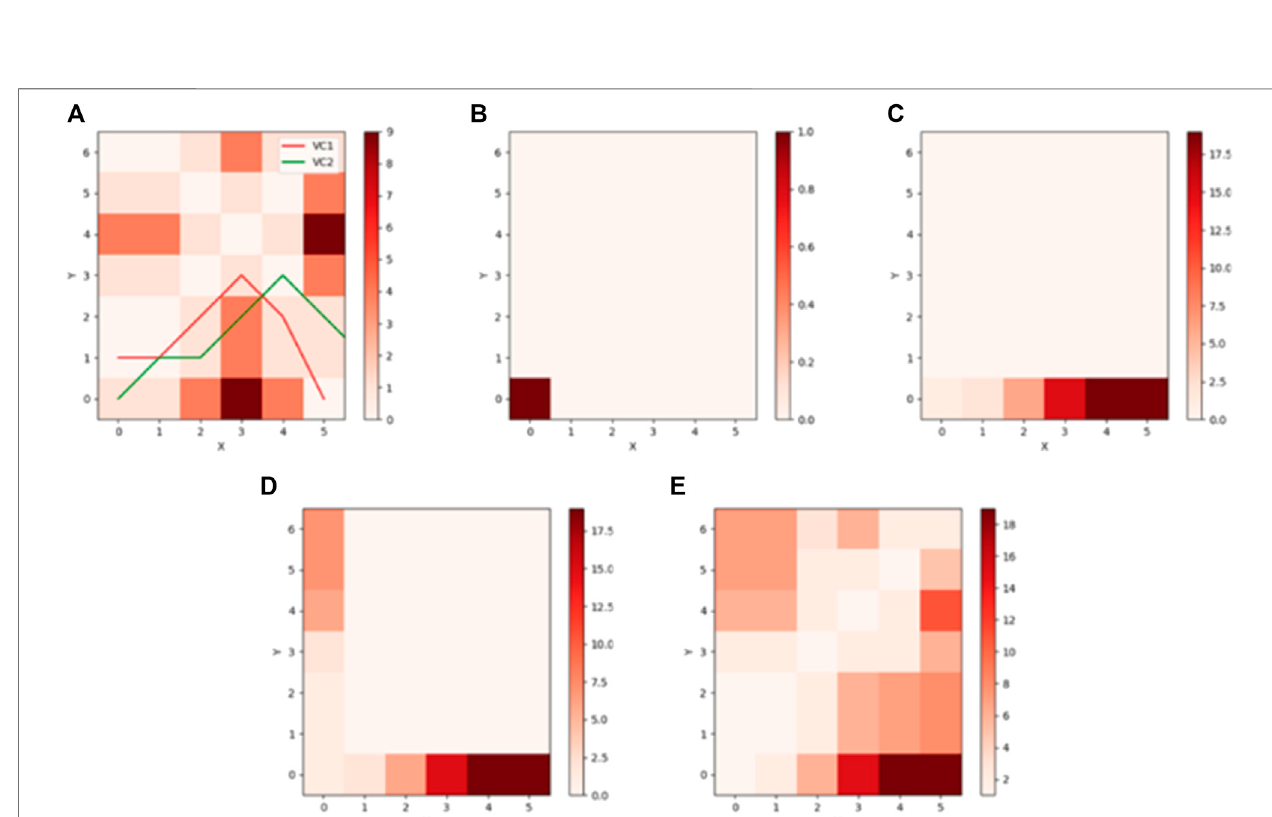
FIGURE 6 | Sequence distance matrix calculation.